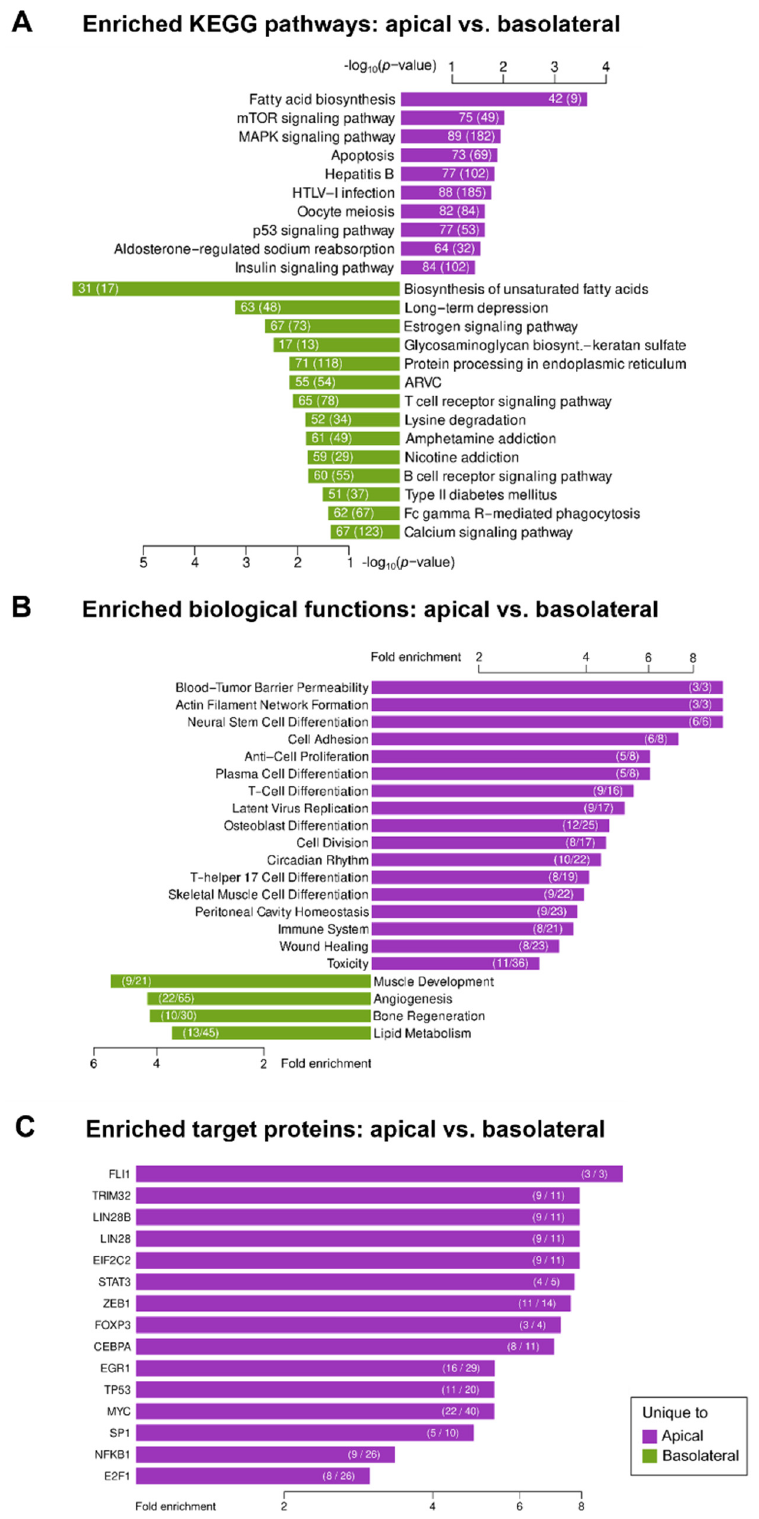
Figure 6. Functional analysis of miRNAs differentially expressed in EVs released by bronchial epithelial cells to the apical versus basolateral compartments. ( A ) KEGG pathway and ( B ) biological functions analyses of differentially expressed miRNAs in both compartments and ( C ) target proteins potentially regulated by the differentially expressed miRNAs. EV—extracellular vesicle.